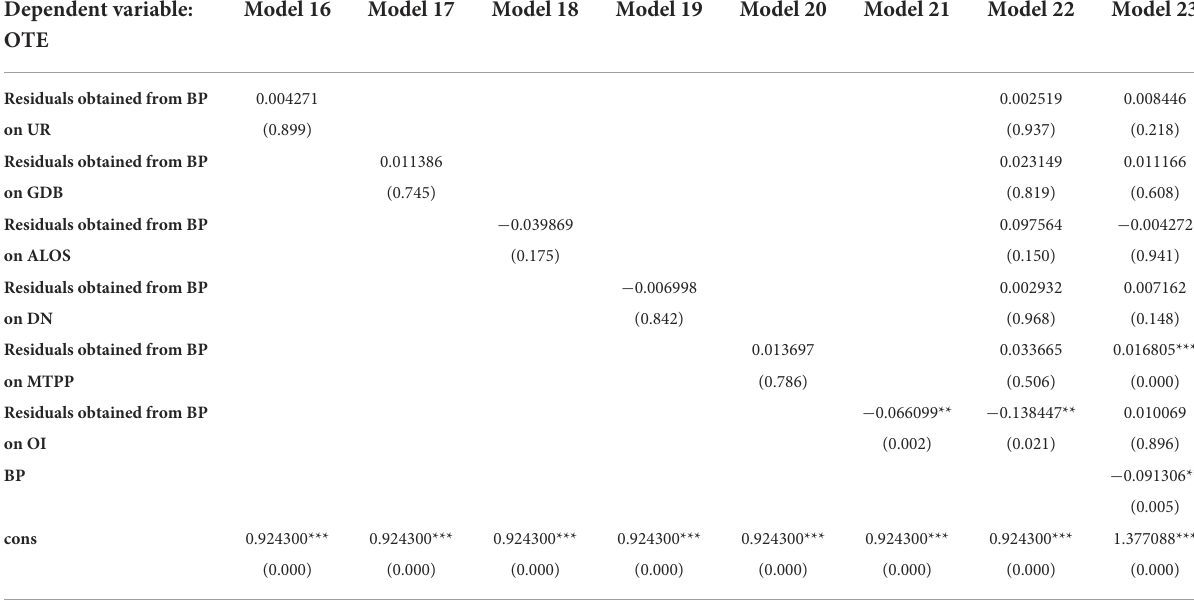
TABLE 13 Results of bootstrapping truncated regression for PHCs: estimations of the residuals from